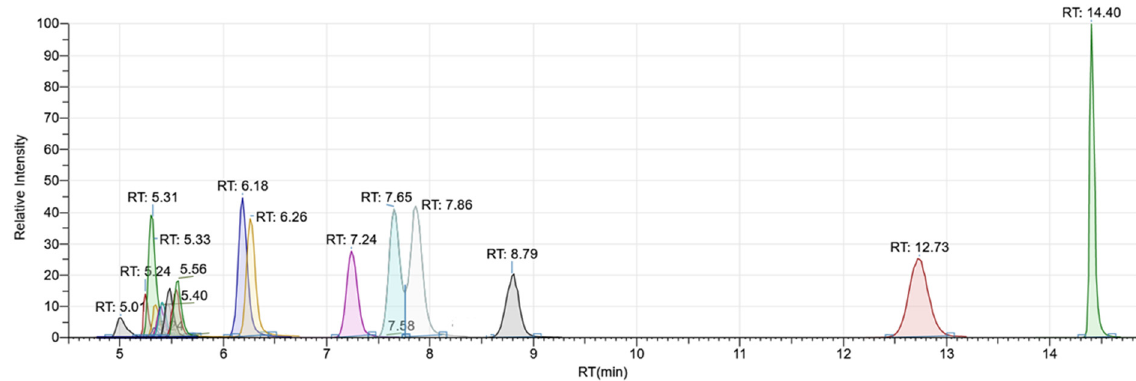
Figure 1. Extracted ion chromatogram (EIC) showing separation of 20 proteogenic amino acids using a C18 reversed phase column with a linear gradient of 2–100% solvent B over 20 min.